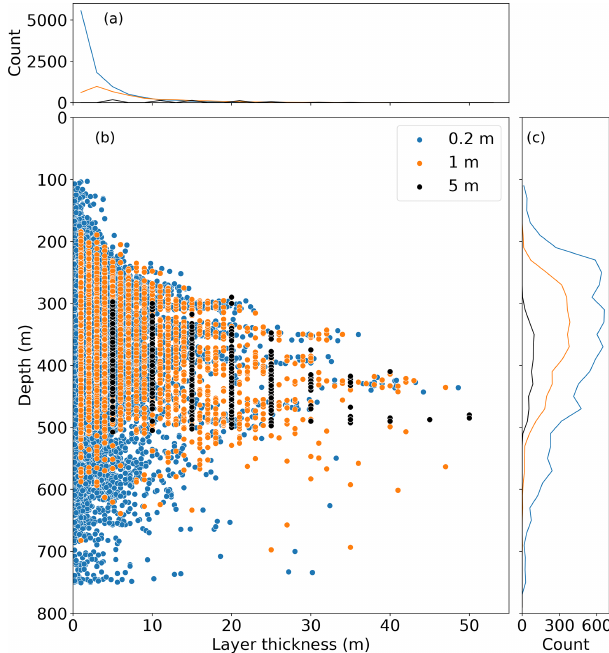
Figure 13. All mixed layers identified from SG620 fast-response thermistor data when binned at 0.2, 1 and 5m. Lines in (a) and (c) are the binned total number of points in (b) with bin widths of 2 and 20m respectively. Glider data from the tropical North